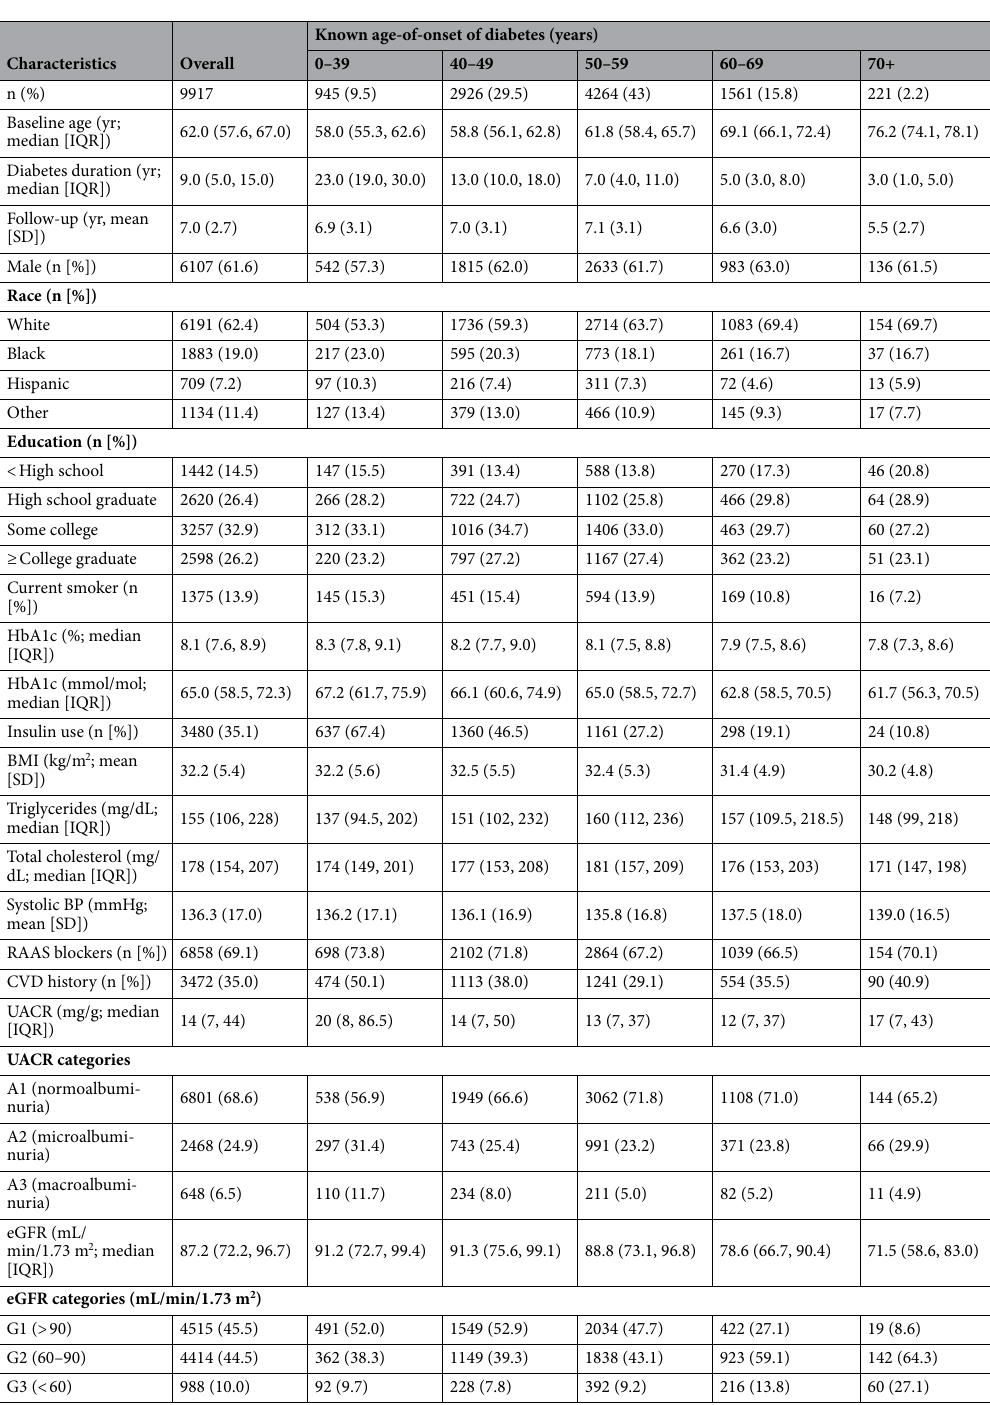
Table 1. Baseline characteristics of study participants according to known age-of-onset of diabetes. IQR interquartile range, y year-olds, yr year, HbA1c glycated haemoglobin, BMI body mass index, BP blood pressure, RAAS blockers renin–angiotensin–aldosterone system blockers, CVD history cardiovascular disease history, UACR urine albumin-creatinine ratio, eGFR estimated glomerular filtration